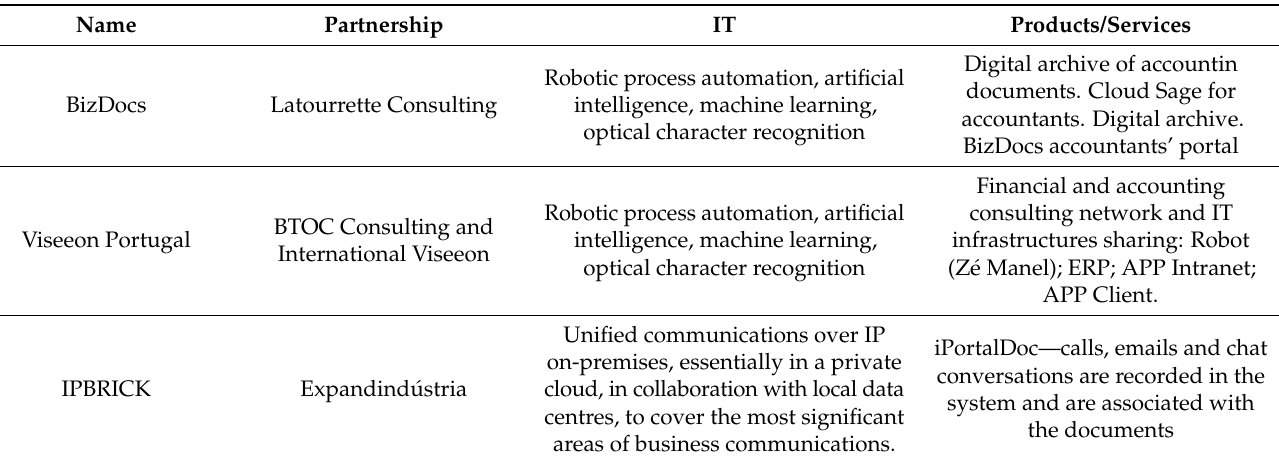
Table 3. The cases and IT